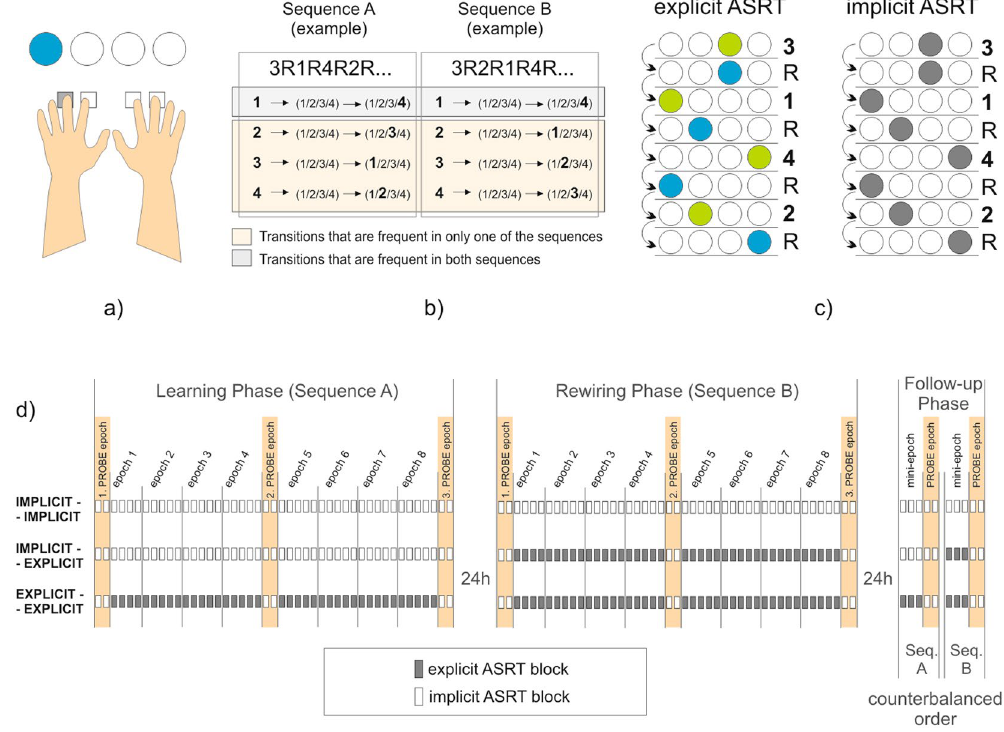
Figure 1. Methods and procedure. ( a ) ASRT task: participants were asked to respond to stimuli appearing on one of four locations, and press the corresponding key as fast and as accurately as they could. ( b ) Examples of sequences and their shared/differing transitions. Numbers indicate the locations of stimuli (1, 2, 3 or 4). The notation “R” indicates a random location out of the four possible ones. Knowing what stimulus appeared two trials before enables participants to anticipate the next stimulus as there is always a highly probable continuation (highlighted) and three less probable continuations. In Sequence A, for example, two trials after encountering a stimulus on the 2nd location, the most probable stimulus is one on the 3rd location (all the remaining possibilities being equally less likely). Sequence A and Sequence B share some of their transitional probabilities (e.g. encountering stimulus on the 4th location two trials after encountering one on the 1st location); and they differ on others (e.g. encountering stimulus on the 3rd location predicts a stimulus on the 2nd location two trials later in Sequence B, but not in Sequence A). Interference effects could be detected by contrasting the magnitude of learning of changed and unchanged sequence parts. ( c ) In the implicit version of the task, random and pattern trials appeared in the same color, thus they were indistinguishable to participants. In the explicit version of the task, random and pattern trials were of different colors, and participants were asked to keep track of the repeating pattern. ( d ) There were 85 trials in a block. There were 45 blocks in the Learning and Rewiring Phase, collapsed into bigger sections (epochs) for analysis. Probe epochs were implicit for all participants. Here we focus on experimental epochs (probe epochs led to similar results, for details see Supplementary Results 2.3– 2.4). In the Follow-up Phase, we aimed to test participants’ performance on both sequences after equal amount of practice on each, without introducing much relearning. Therefore only 5 + 5 blocks of both sequences were presented on the third day. Two of these blocks were probe